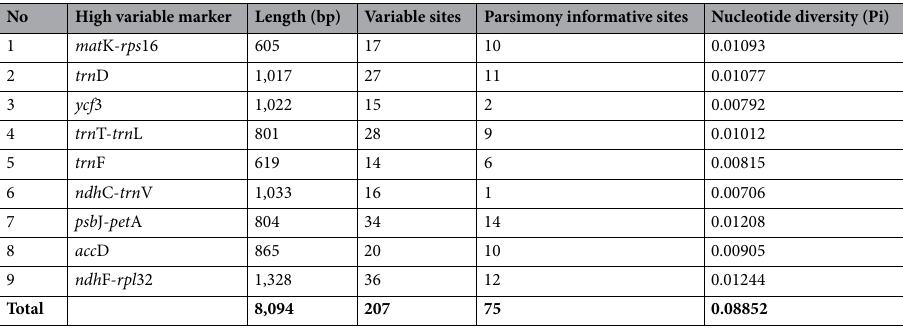
Table 1. A correct version of the original Table